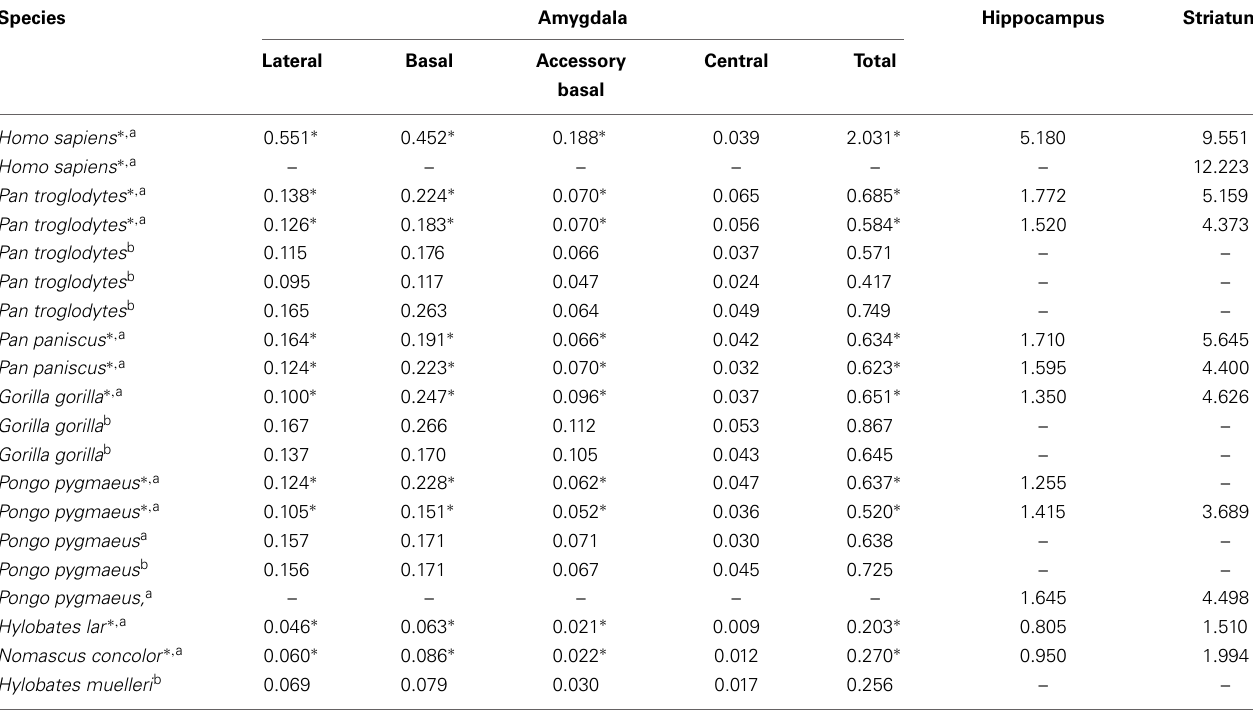
Table 1 | Volume of amygdala, hippocampus, and striatum in hominoid species collected with stereological methods.